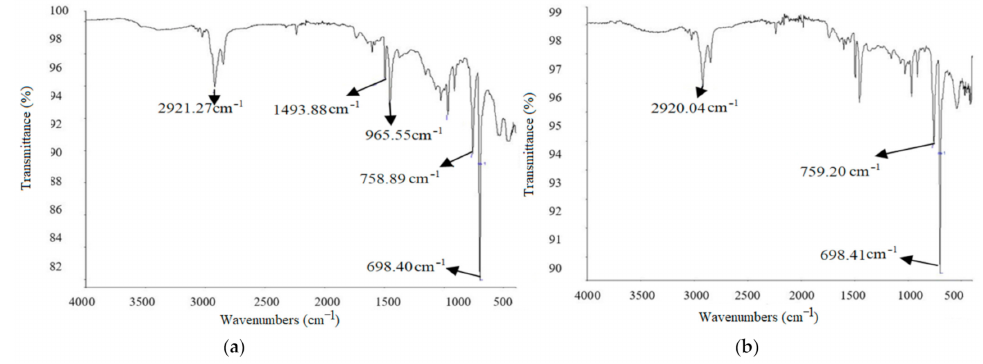
Figure 16. FTIR graphs of ABS composites: ( a ) C5 and ( b ) C6